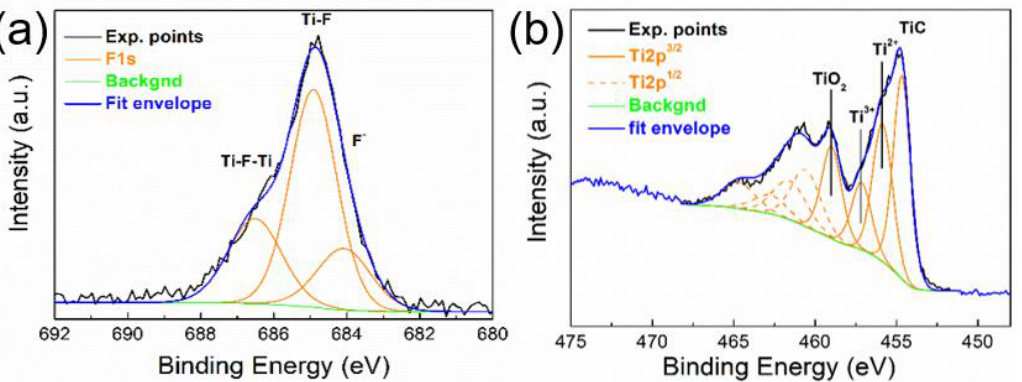
Figure 3. XPS ( a ) Ti2p and ( b ) F1s region of MXene.